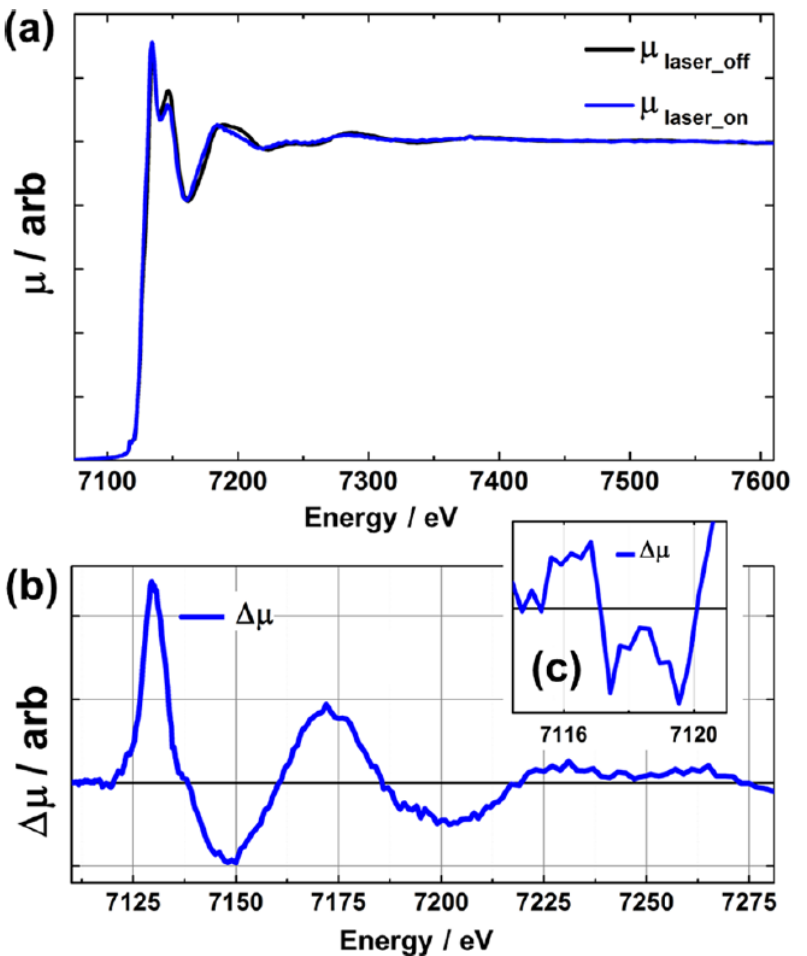
Figure 22. ( a ) X-ray absorption spectra for the ground state of the Fe II complex (black line), and 150 ps after photoexcitation (λ = 400 nm) (blue line), ( b ) transient XAS spectrum and ( c ) close-up of the pre-edge region. Figure reproduced with permission from Zhang et al. [163]. Copyright (2019) American Chemical Society.